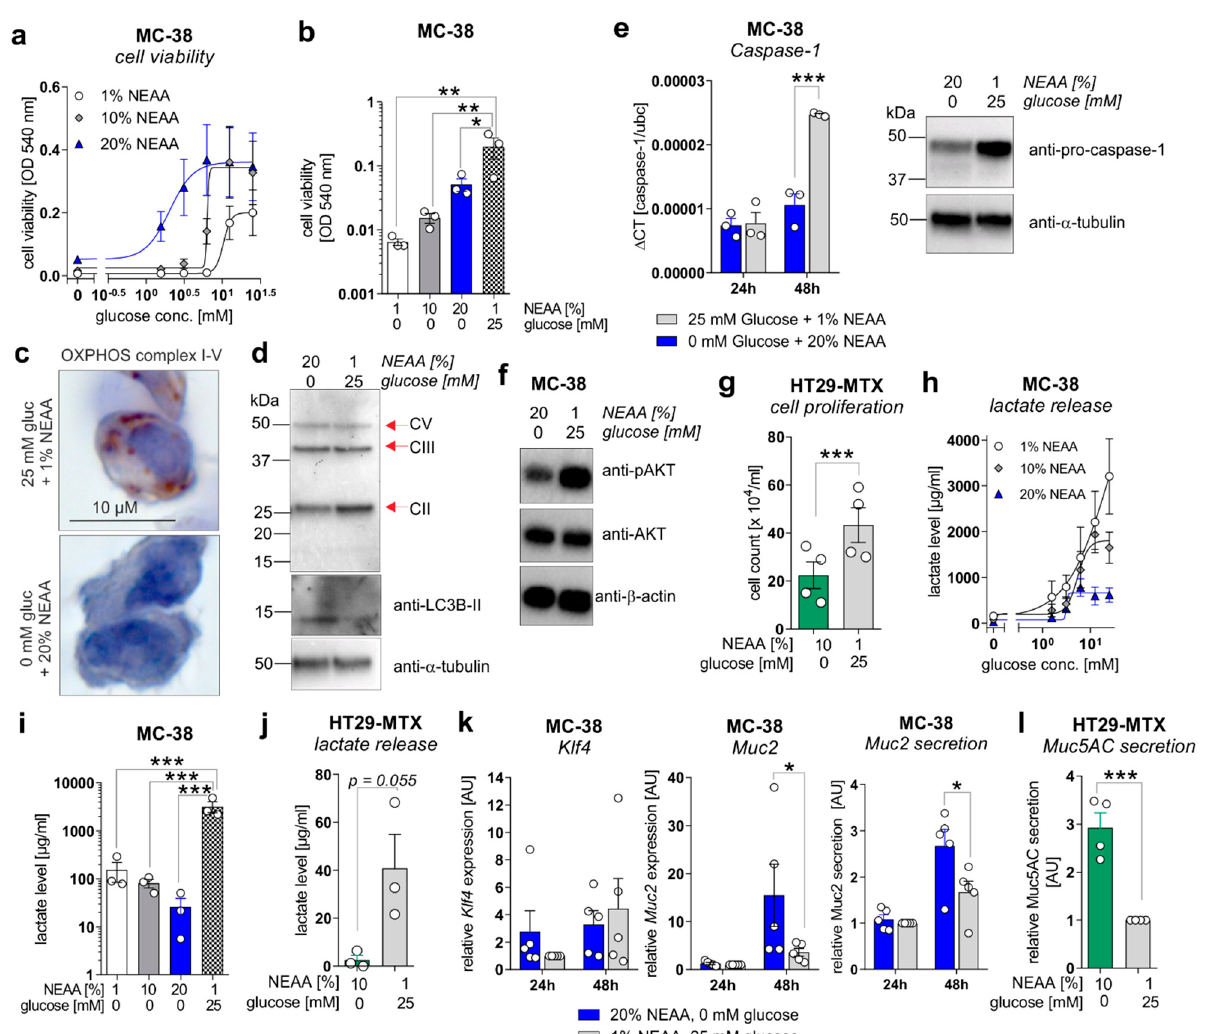
Figure 5. A metabolic shift from aerobic glycolysis towards amino acid metabolism inhibits proliferation but enhances goblet cell differentiation of CRC cell lines in vitro. ( a , b ) MC-38 cells were incubated in culture media containing increasing concentrations of D-glucose (0–25 mM) in the presence of 1%, 10%, or 20% NEAA. After 72 h, cell viability was determined by neutral red cytotoxicity assay. ( c ) Representative images of immunohistochemistry staining of paraffin-embedded MC-38 cells after 48 h cultivation under standard (25 mM glucose + 1% NEAA) or glucose-free (0 mM glucose + 20% NEAA) conditions, utilizing an antibody cocktail against OXPHOS complexes I–V. ( d ) MC-38 cells were incubated in standard culture medium (25 mM glucose, 1% NEAA) or in glucose-free plus 20% NEAA medium for 48 h. Expression of OXPHOS complexes II, III, and V or LC3B were analyzed by Western blot experiments. Alpha-Tubulin expression served as a loading control (representative images of n = 3 independent experiments). ( e ) MC-38 cells were incubated in a standard culture medium (25 mM glucose, 1% NEAA) or glucose-free plus 20% NEAA medium for 24 or 48 h. Caspase-1 mRNA expression was quantified by qPCR experiments and related to Ubc mRNA expression (left panel; n = 3 independent experiments). Caspase-1 protein expression after 48 h of incubation was analyzed by Western blot experiments. Alpha-Tubulin expression served as a loading control (right panel; representative images of n = 3 independent experiments). ( f ) Protein levels of phosphorylated AKT and AKT were determined after 48 h of incubation of MC-38 cells under indicated culture conditions by Western blot experiments. β -actin expression served as a loading control. Representative images of n = 3 independent experiments. ( g ) HT29-MTX cells were incubated for 72 h under indicated culture conditions and cell count was determined. Mean ± SEM of four independent experiments is presented. ( h , i ) MC-38 cells were incubated under indicated culture conditions. After 72 h, L-lactate levels were quantified in cell culture supernatants. ( j ) L-lactate release by HT29-MTX cells after 72 h of incubation under indicated culture conditions. L-lactate concentrations were related to the respective cell count presented in ( g ). Mean ± SEM of three independent experiments is presented. ( k ) MC-38 cells were incubated in